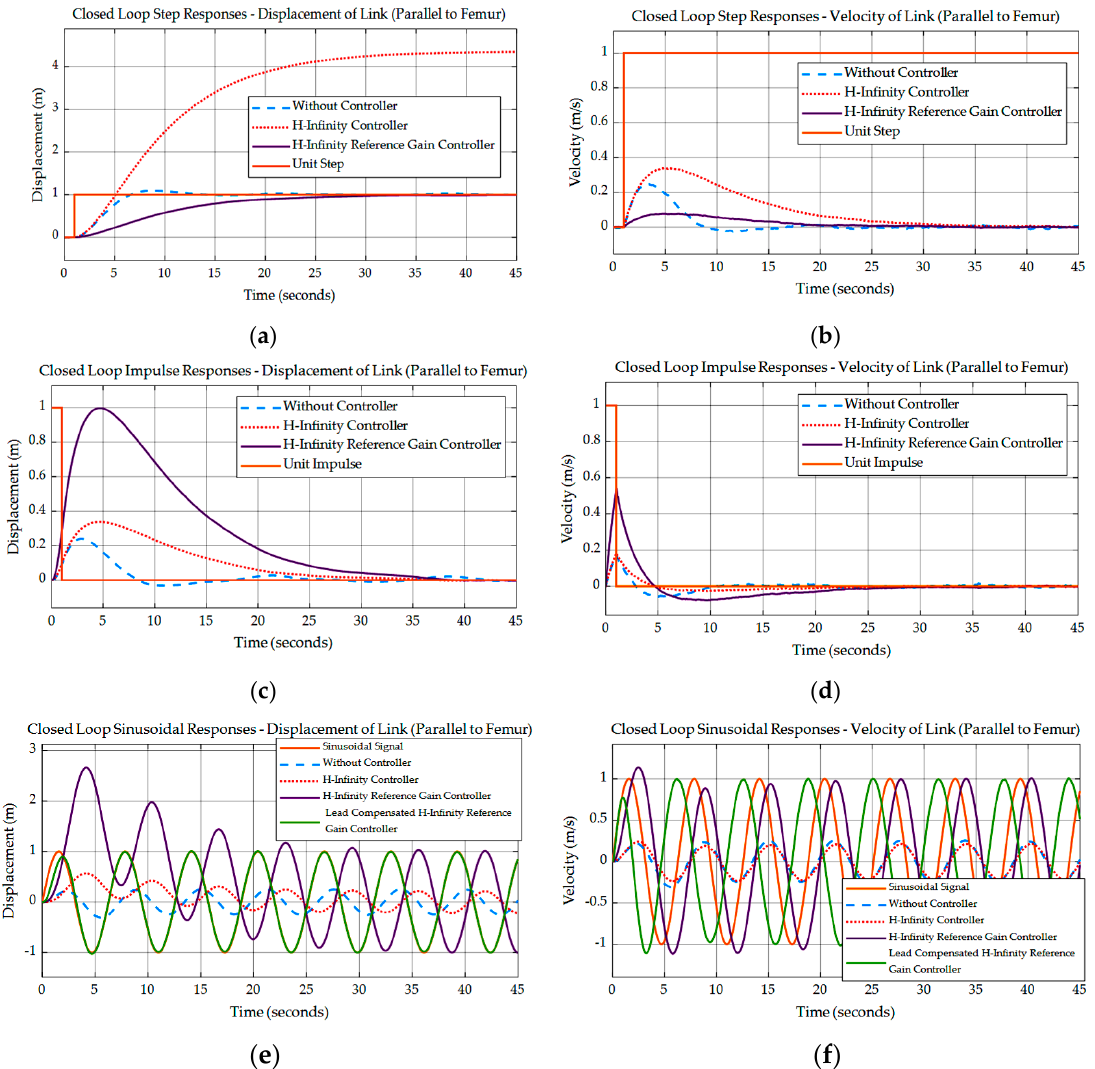
Figure 6. Model-based robust control design-closed loop responses of link (parallel to femur) ( a ) step responses—displacement; ( b ) step responses—velocity; ( c ) impulse responses—displacement; ( d ) impulse responses—velocity; ( e ) sinusoidal responses—displacement; ( f ) sinusoidal responses—velocity.